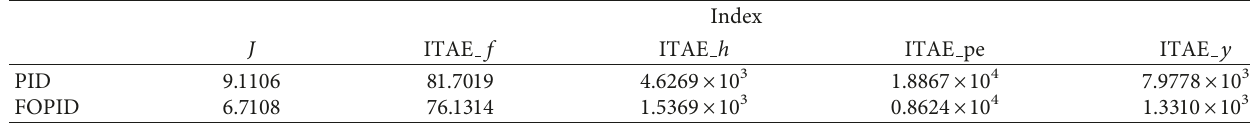
Table 13: Performance indicators with Δ f � + 0 . 5Hz.